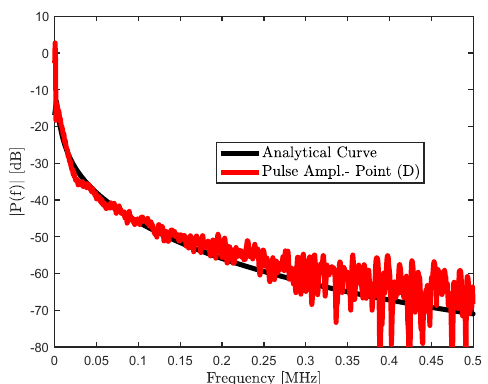
FIGURE 8. Power spectra comparison between the analytical pulse and measurement at point D, from Fig 2.